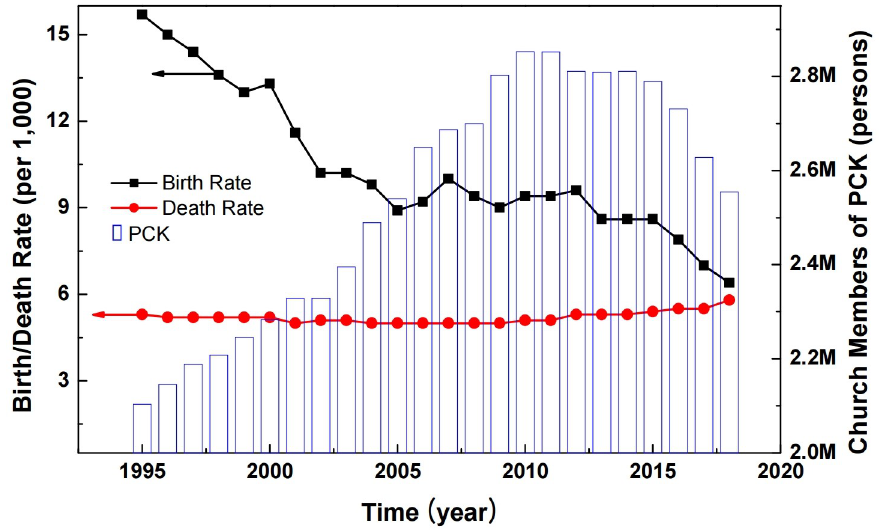
Fig 5. The real birth and death rates for South Korea between 1995 and 2018 are depicted by solid squares and solid circles, respectively. The historical population of the PCK is illustrated with the bar graph (S5 Fig).